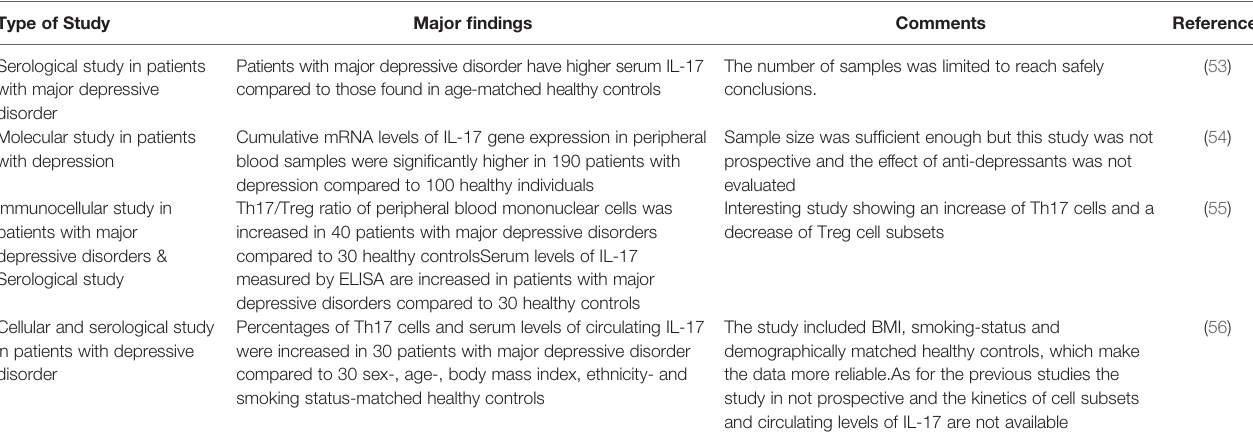
TABLE 1 | A summary of human studies reporting on the role of IL-17 in